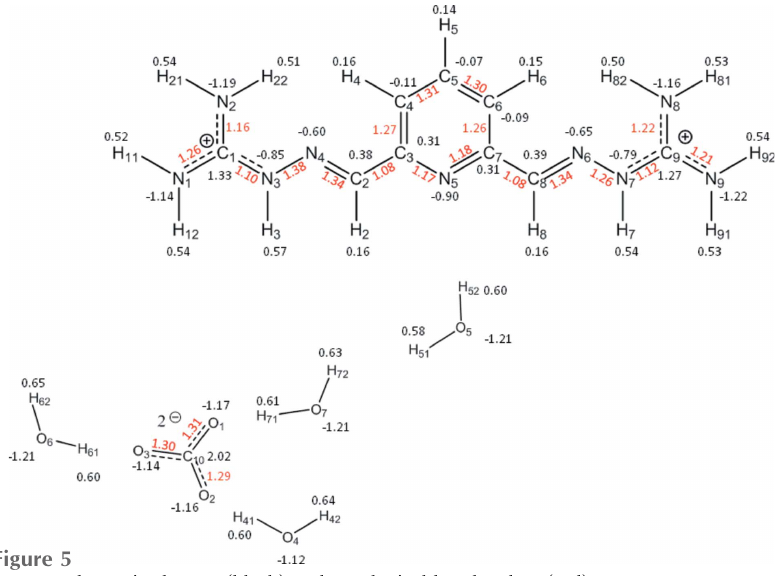
Figure 5 Integrated atomic charges (black) and topological bond orders (red).